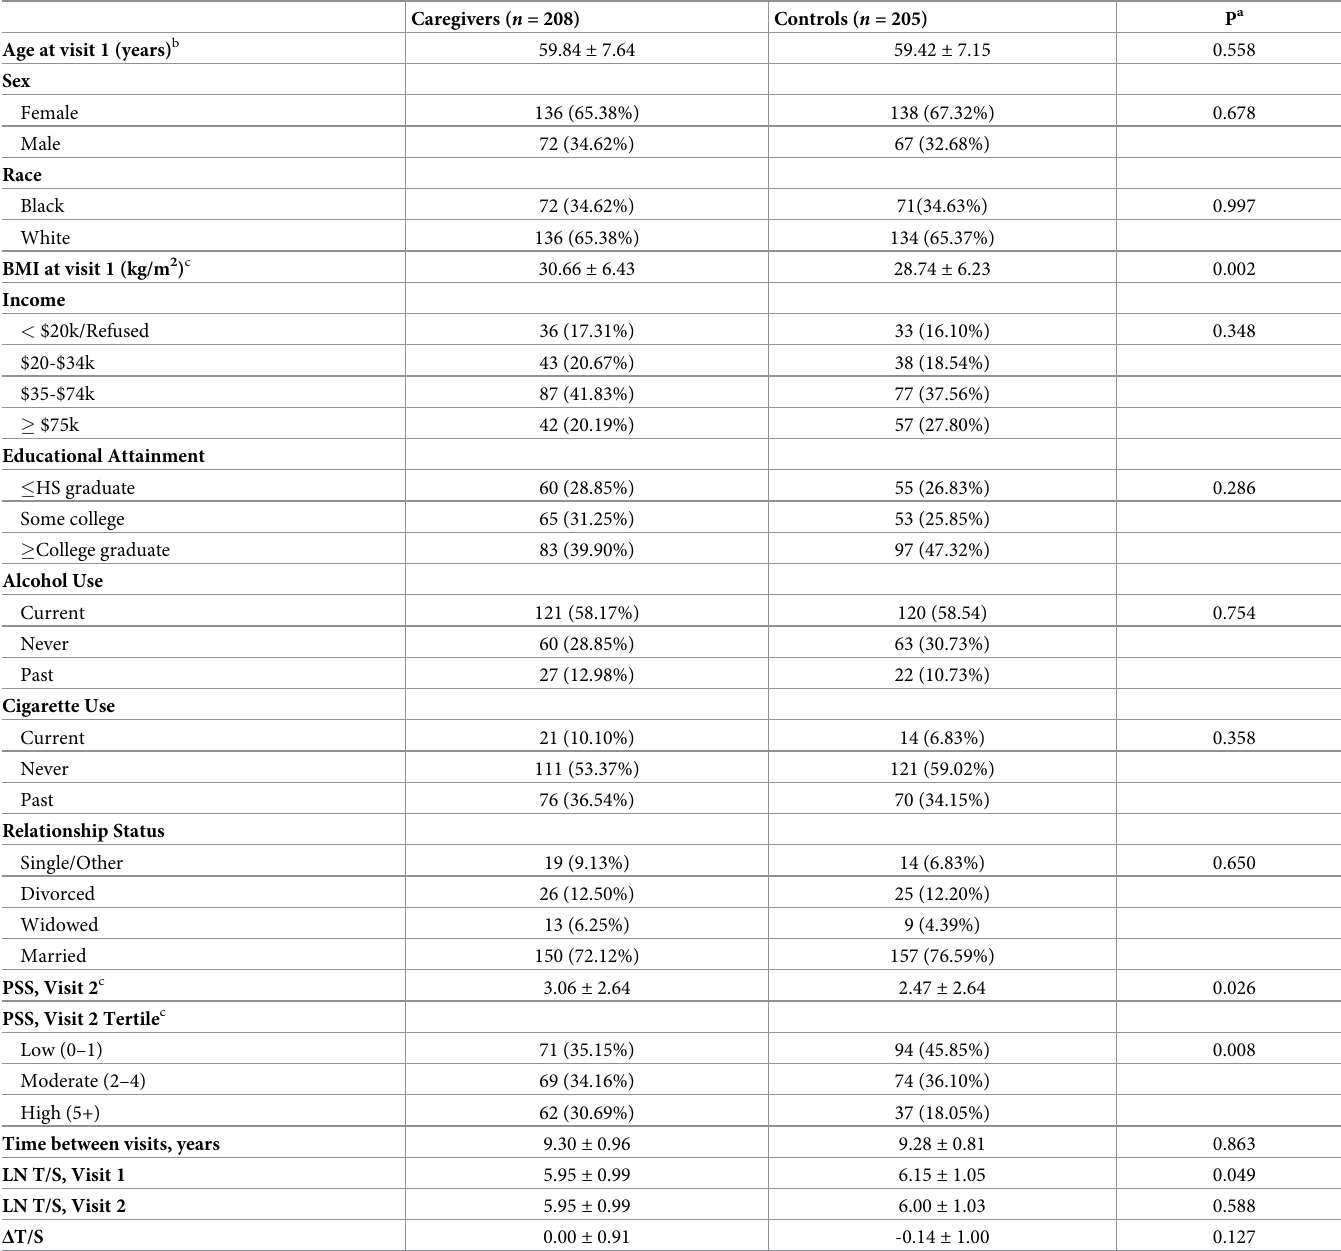
Table 1. Descriptive characteristics for incident caregivers and non-caregiving